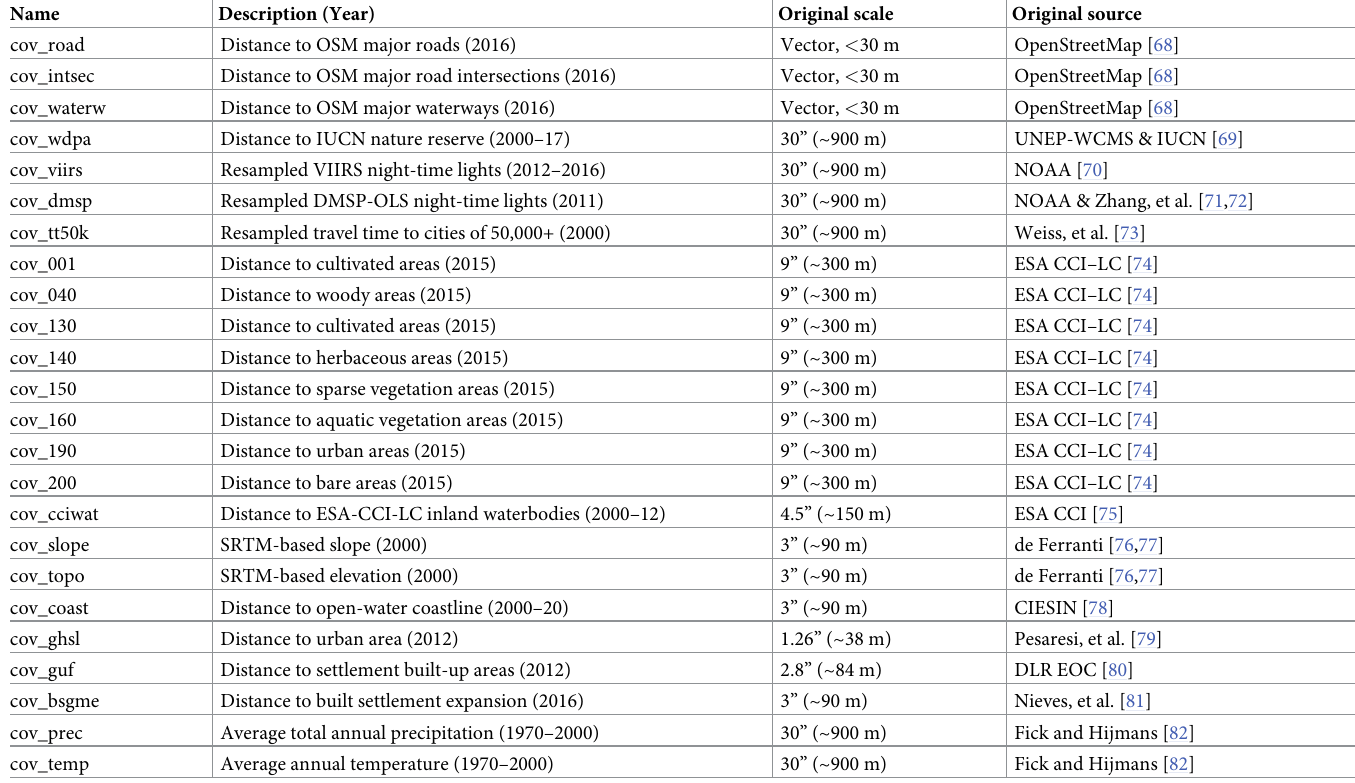
Table 3. Covariate data sources for Random Forest gridded population